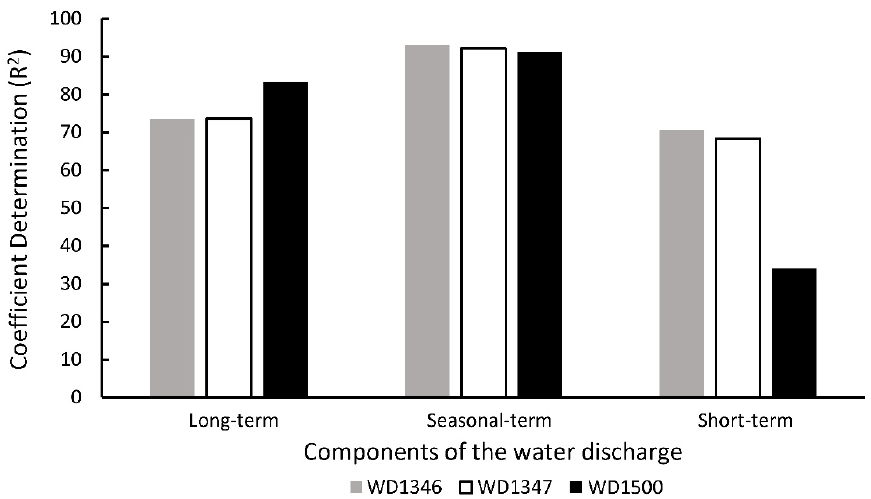
Figure 9. The coefficient determination (R 2 ) of the different time series components for the three water discharge USGS monitoring stations (WD1346, WD1347, WD1500 ) from the multi linear regression water discharge USGS monitoring stations (WD1346, WD1347, WD1500) from the multi linear application . regression